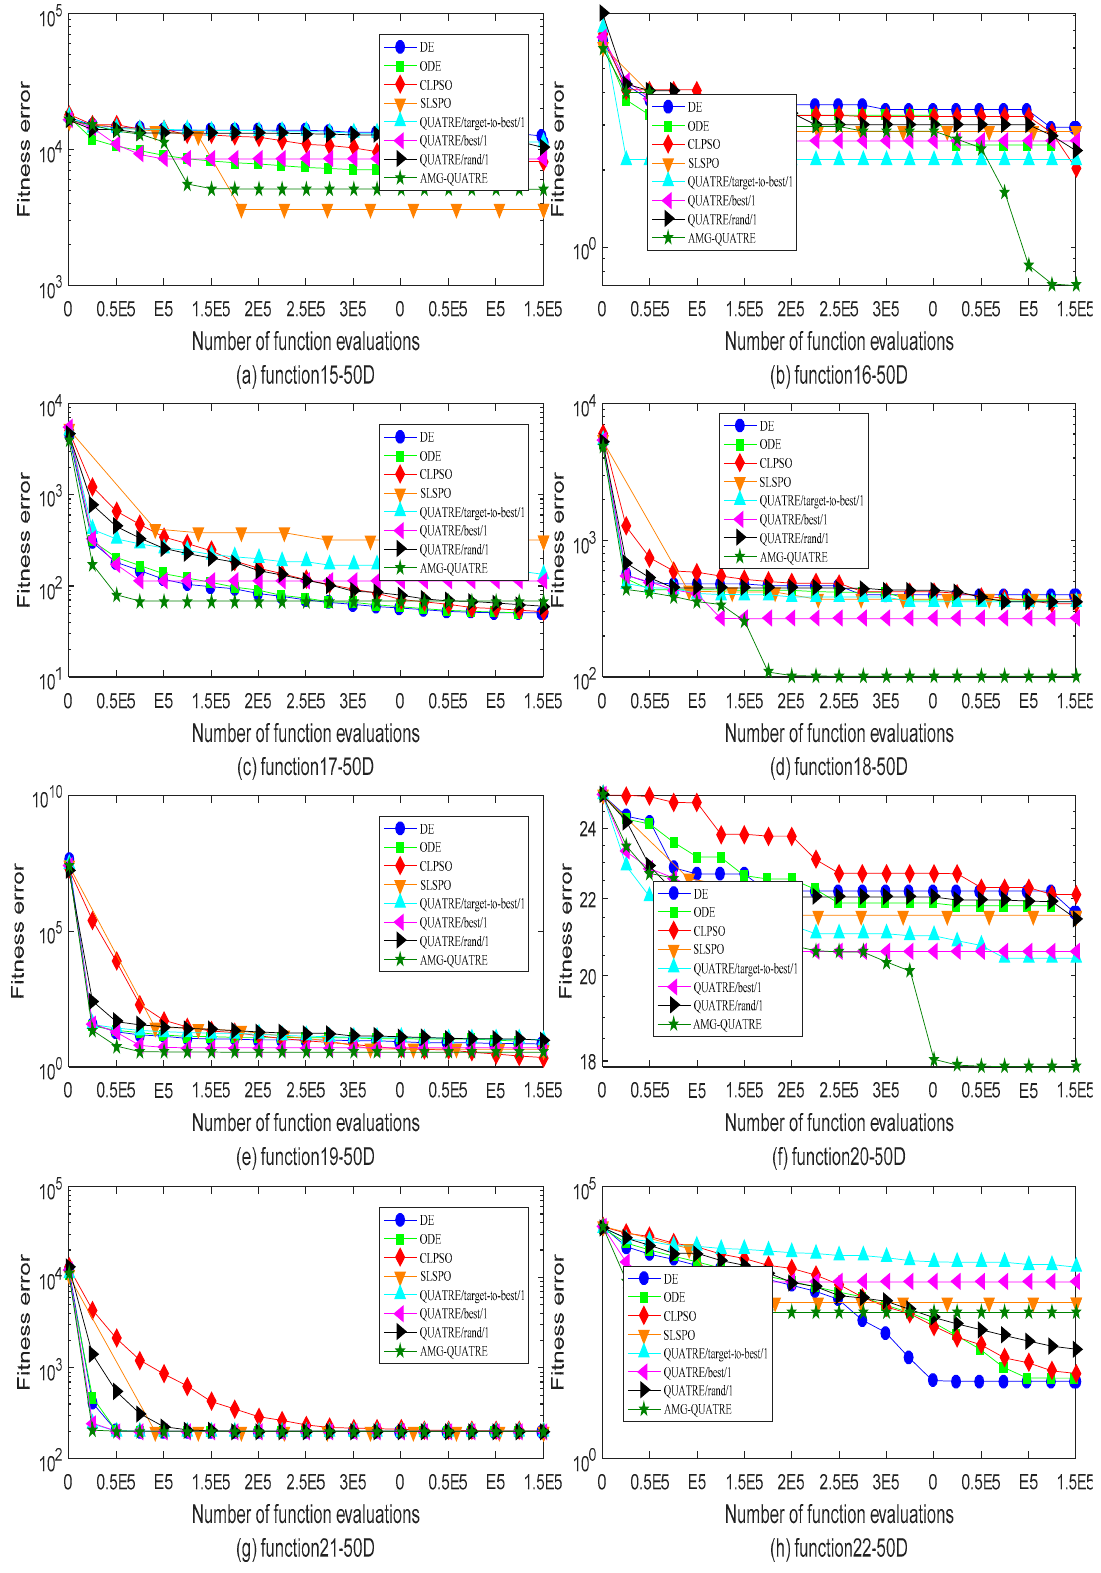
Figure 5. Comparison of the best of fitness errors for functions f 15 – f 22 with 50D optimization. ( a ) f 15